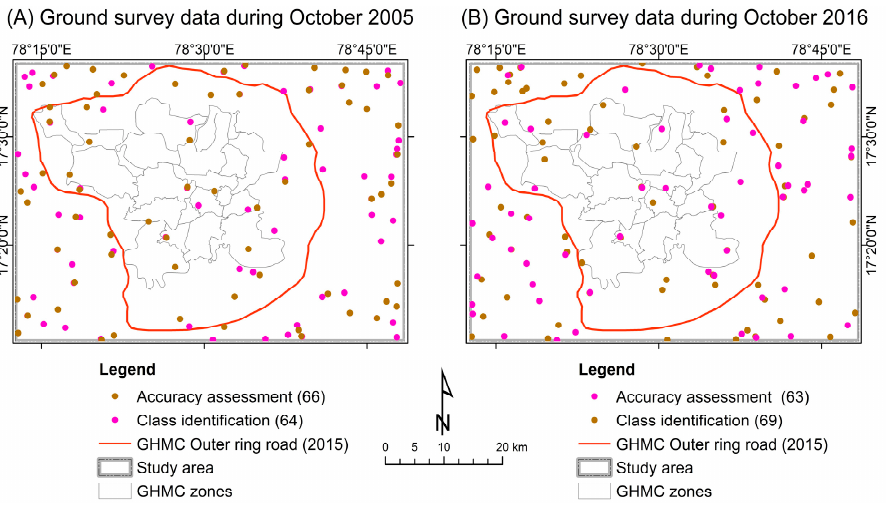
Figure 3. Spatial distribution of ground survey data in the study area in different periods.